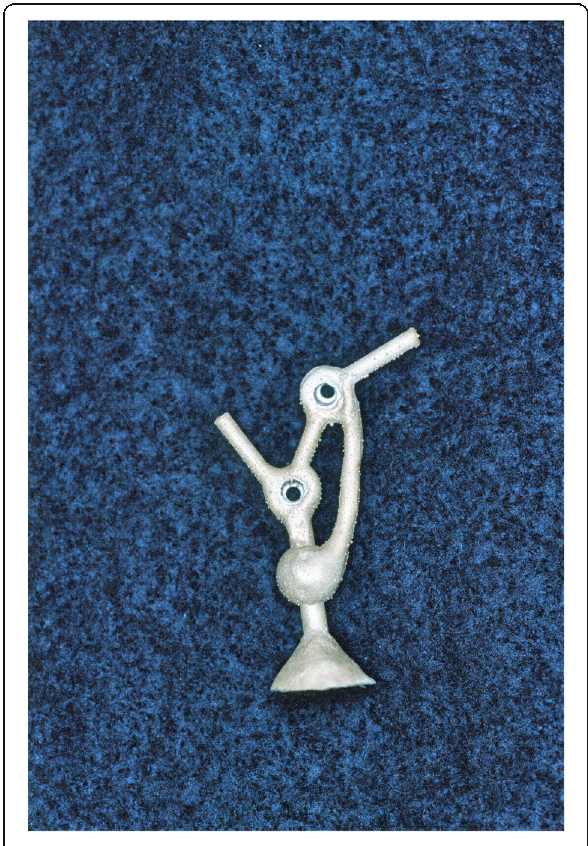
Fig. 6 Framework designed to fit under the helix Fig. 7 Retention bar cast in type III gold